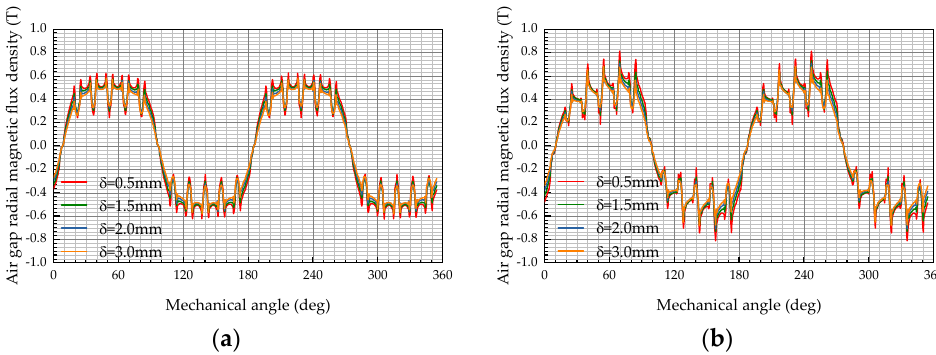
Figure 2. Radial air − gap flux density under no load and rated load: ( a ) no ‐ load; ( b ) rated ‐ load.